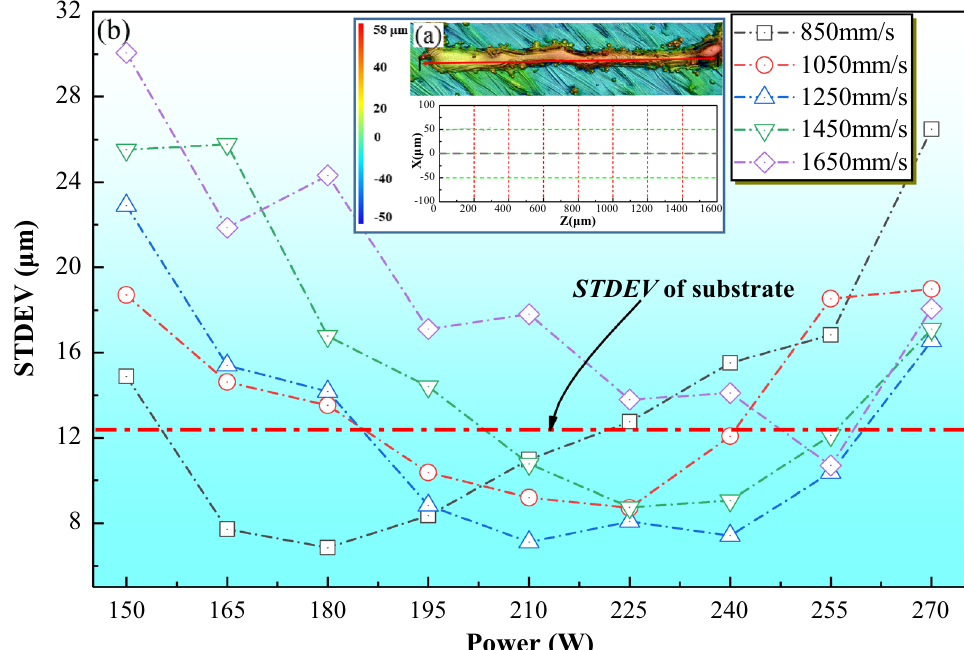
Figure 4 a Data measurement method, and b Variation of STDEVs with laser